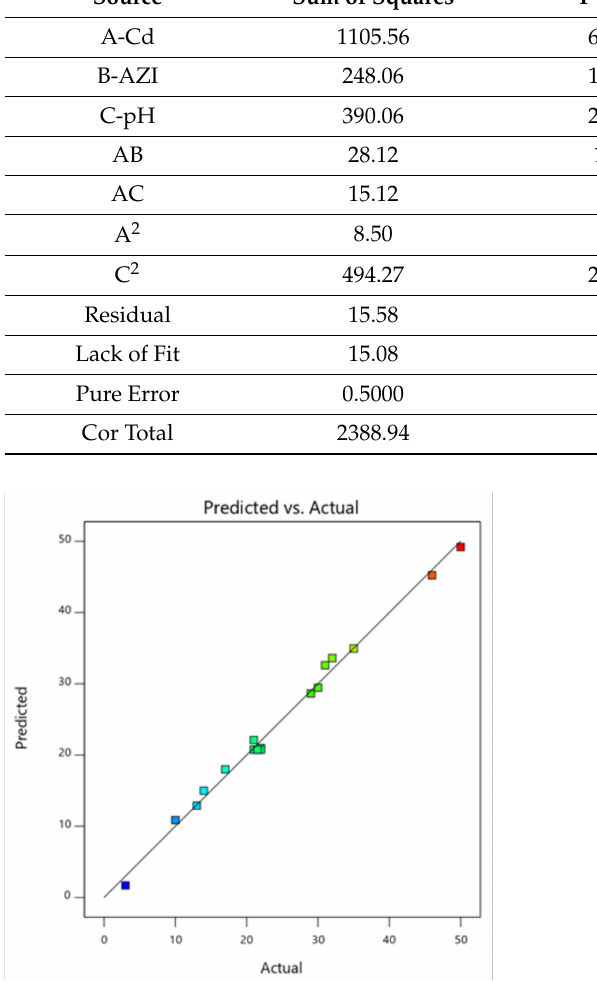
Figure 3. Experimental vs. predicted data from RSM describing PNR